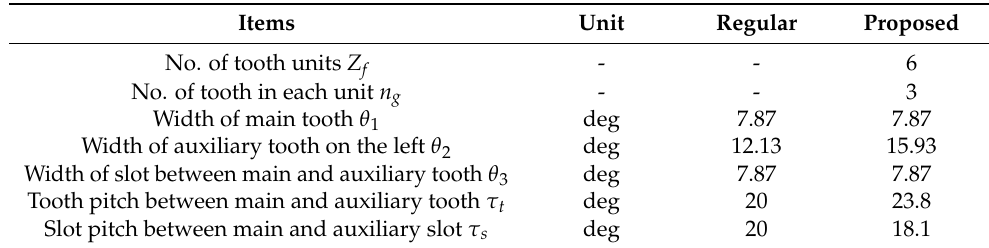
Table 4. Parameter comparison of one unit tooth structure.